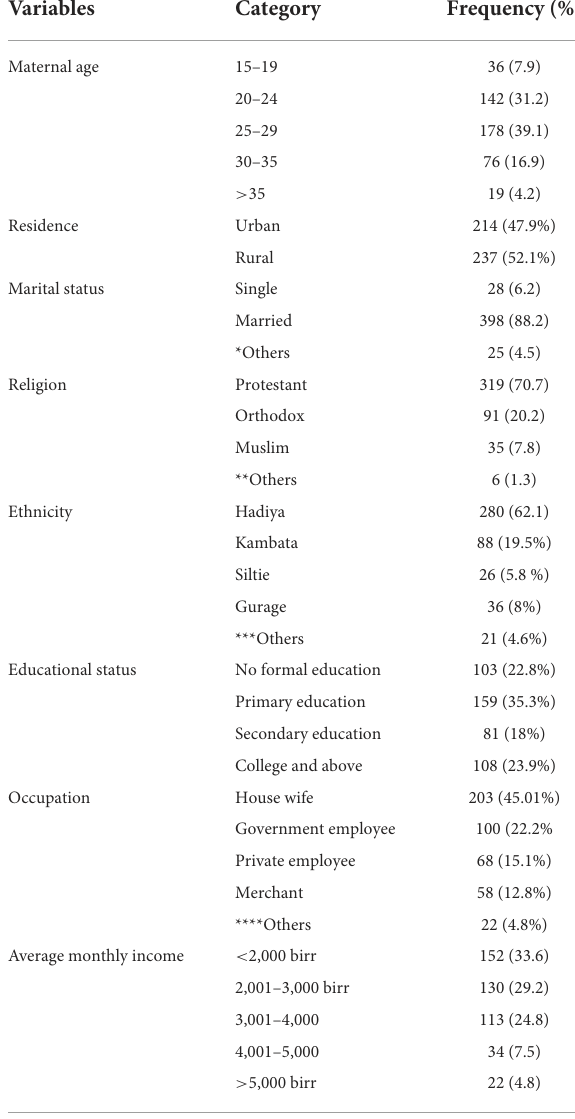
TABLE 1 Sociodemographic characteristics on respectful maternity care among mothers who gave birth at Hadiya Zone public hospitals Southern Ethiopia, 2020 ( n =